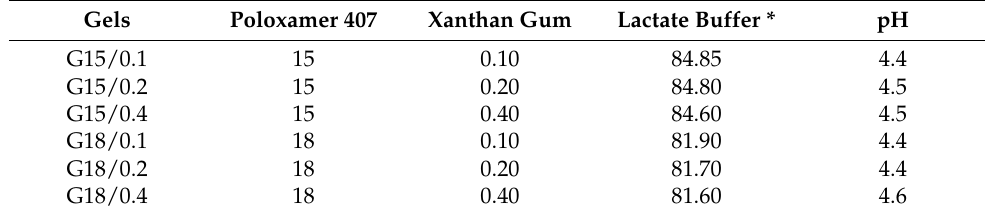
Table 1. Gel compositions and pH.